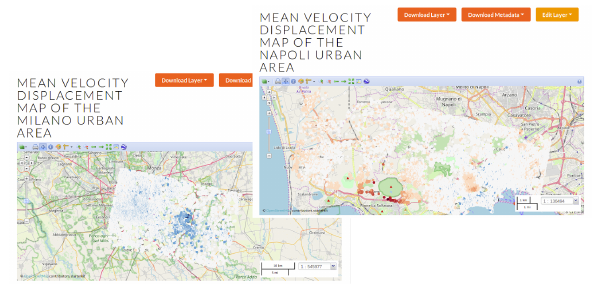
Figure 2. Mean deformation velocity maps of Milan and Naples deployed in the IREA data node, accessed via WMS